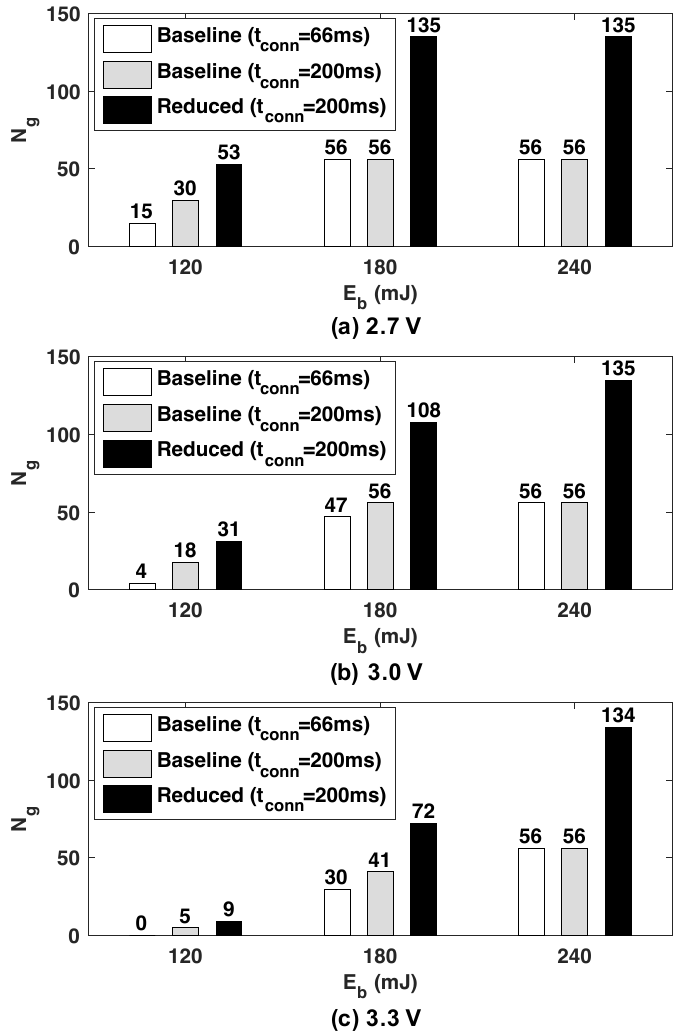
Figure 10. Comparison of the number of recognized gestures for various energy budgets and energy storage